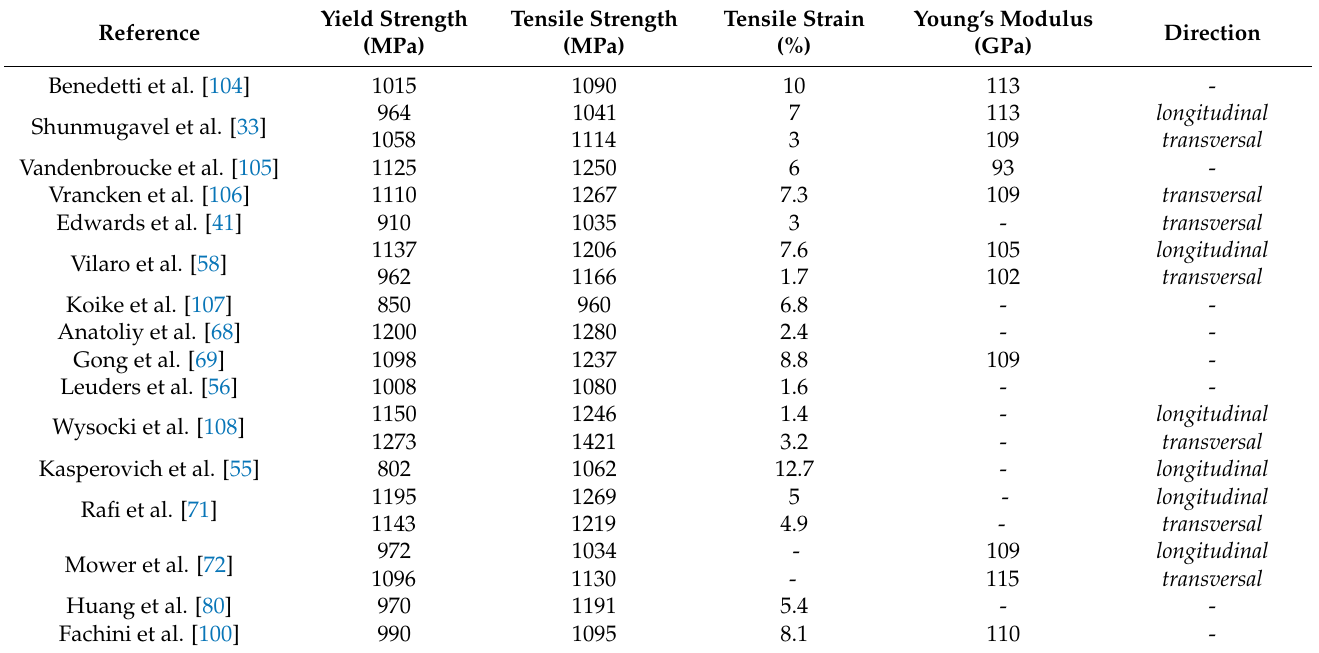
Table 3. Tensile properties of LPBF Ti6Al4V, indicating the testing direction with respect to the building